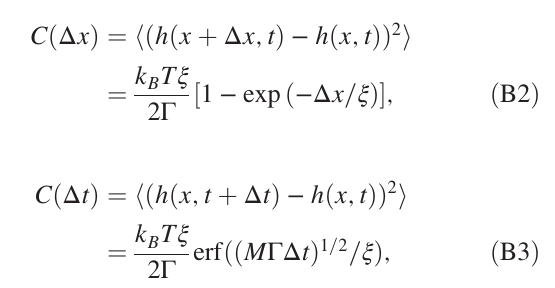
FIG. 8. Lag plots of